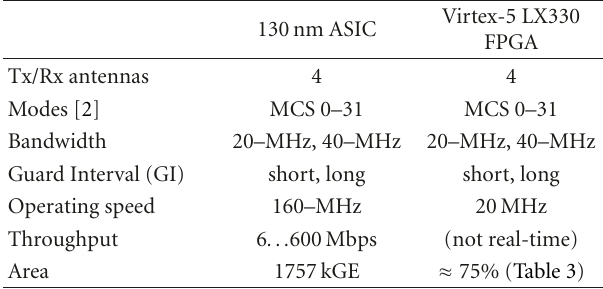
Table 2: Key figures of the 802.11n design [32] on di ff erent platforms.